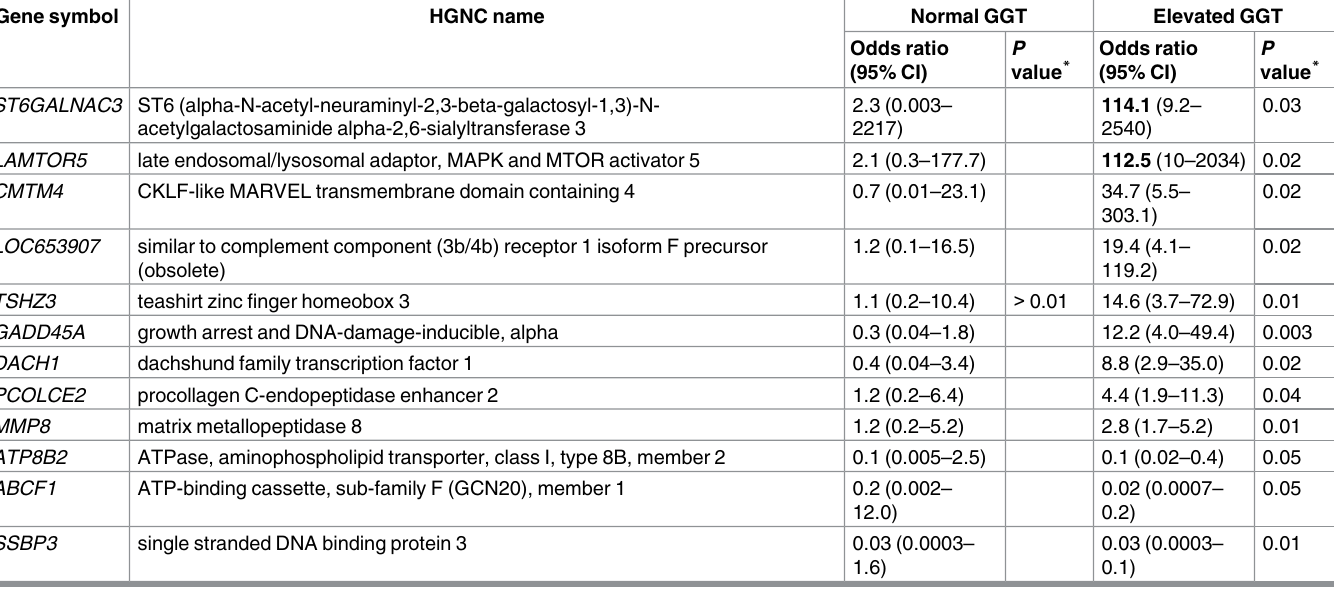
Table 2. List of 12 genes significantly contributing to IVIG resistance in subgroup with elevatedGGT levels identified by logistic regression from 36 genes found by R 2 statistic and FDR